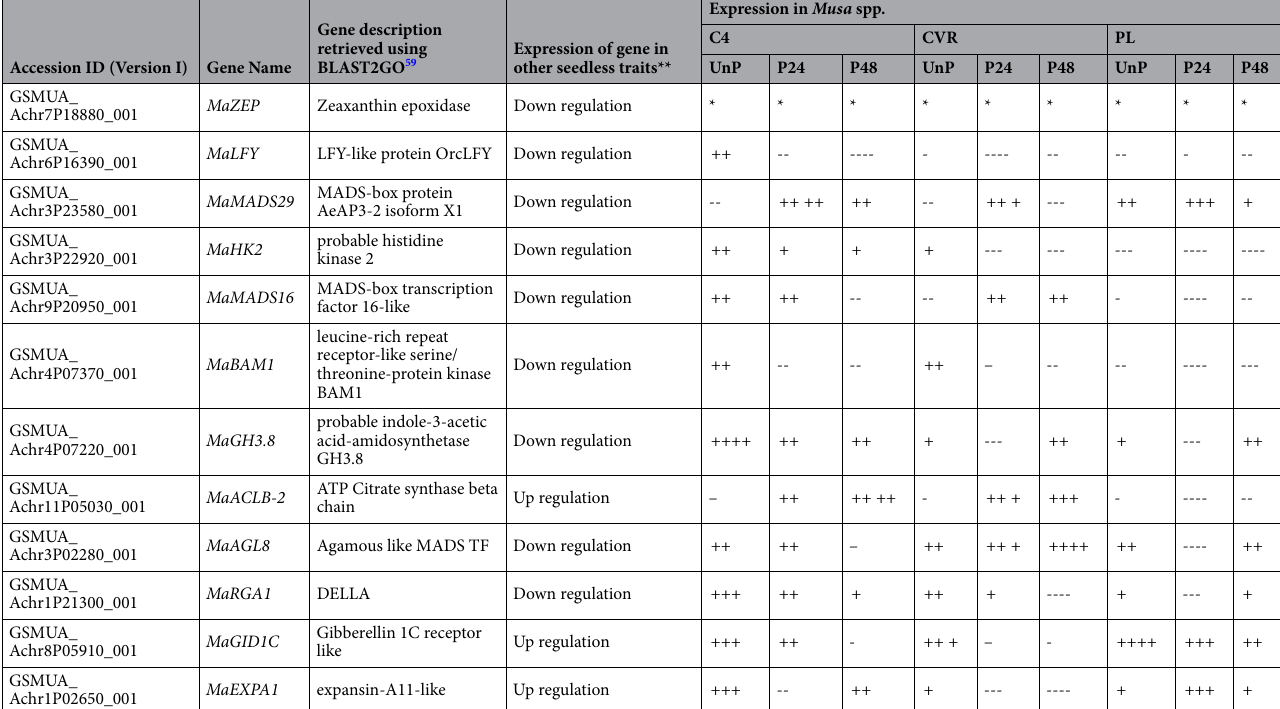
Table 2. Shortlisted candidate genes from the constructed PPI network for the trait parthenocarpy. **References included in Supplementary files. * qRT-PCR expression values is --- & ---- → 2, 3 and fourfold down